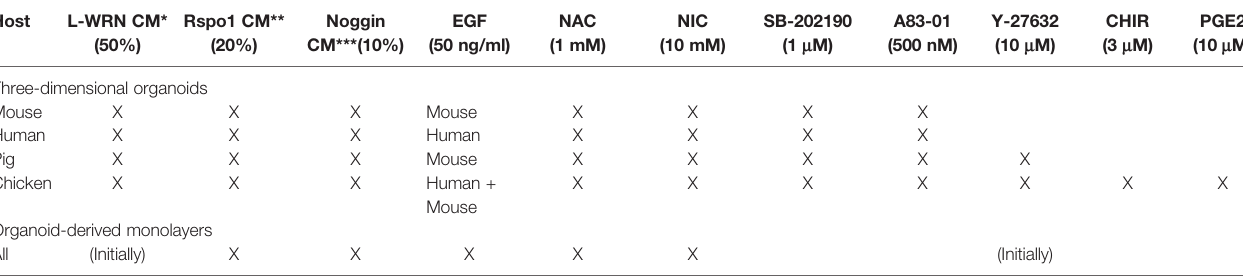
TABLE 1 | Medium conditions for organoid